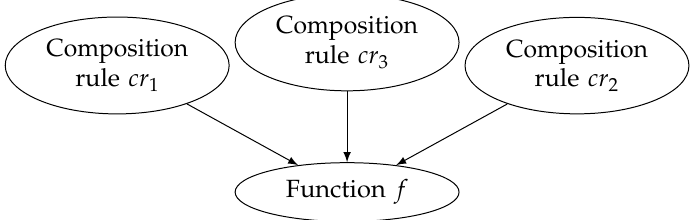
Figure 2. Bayesian network for a functional implication in a probabilistic